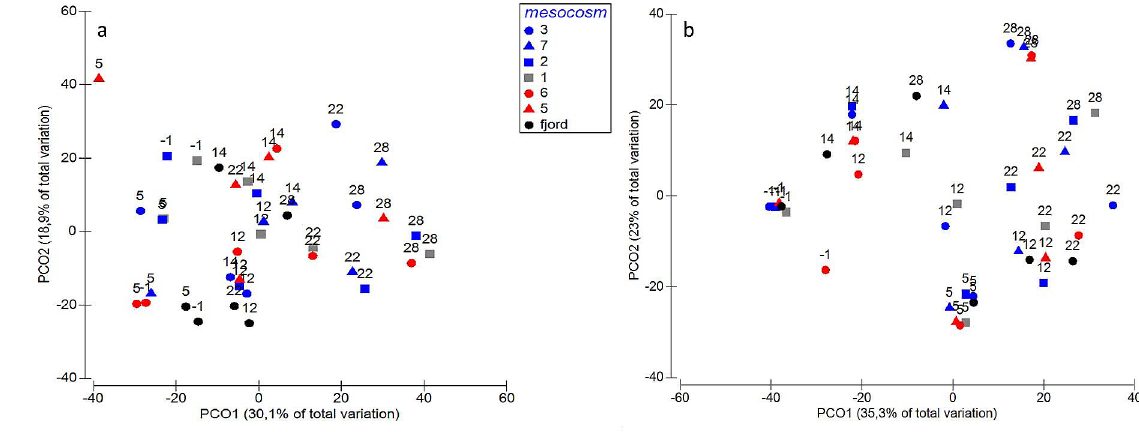
Fig. 2. Principal coordinate analyses (PCO) on a Bray–Curtis similarity matrix of (a) particle-associated community and (b) free-living community. Colours and symbols show mesocosm and treatment level – blue: low CO 2 addition ( ∼ 175–250µatm average over experiment), grey: medium CO 2 addition ( ∼ 600µatm average over experiment) and red: high CO 2 addition ( ∼ 675–860µatm average over experiment). Numbers in the plots denote experiment day.